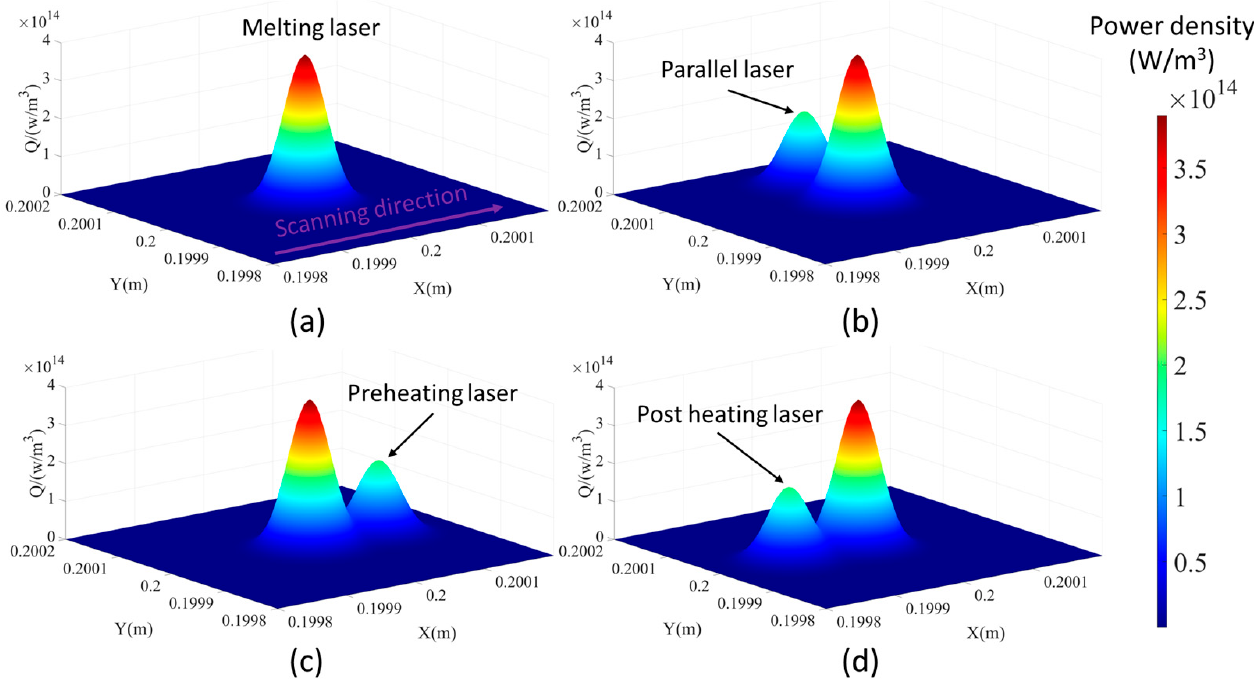
Figure 4. Illustration of the Gaussian distributed heat sources for PBF-LB modelling: ( a ) single laser beam for melting powders; ( b ) parallel of an auxiliary heat source; ( c ) preheating of an auxiliary heat source; and ( d ) post-heating of an auxiliary heat source ( z = 0).